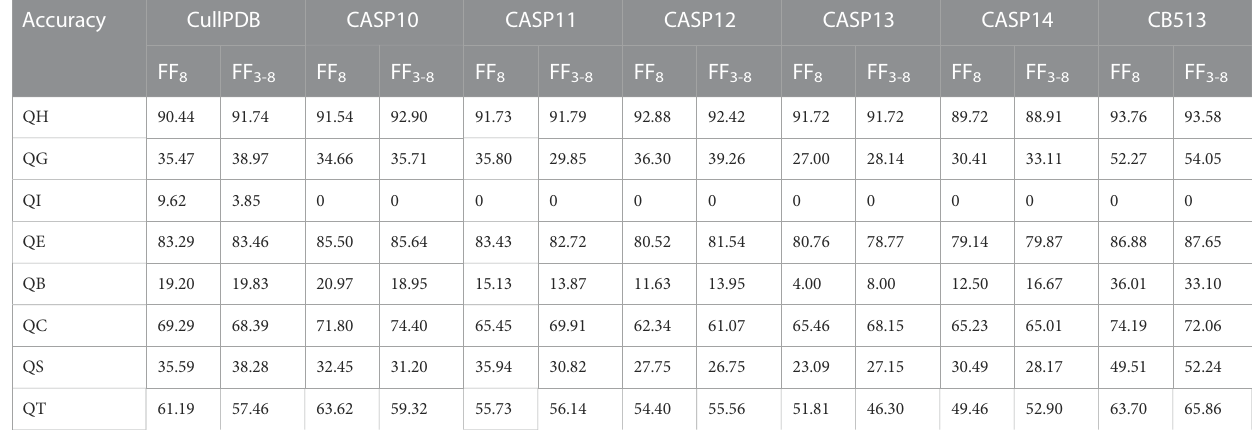
TABLE 7 Single-type accuracy of the proposed model on seven datasets in 8-state PSSP when using FF 8 and FF 3-8 , where F 8 represents the 8-state PSSP feature.